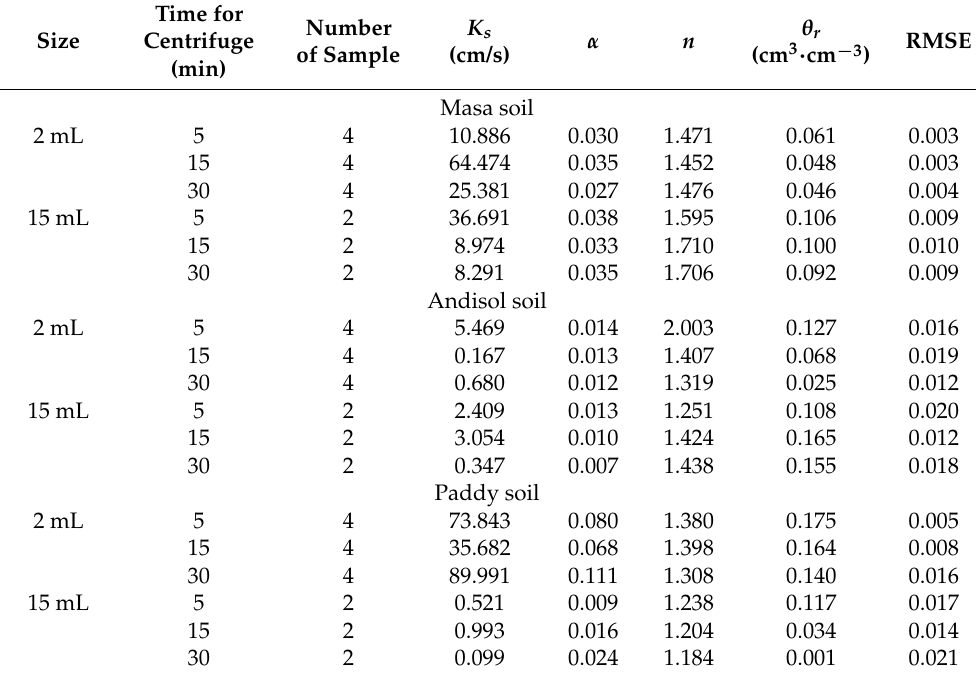
Table 2. Optimization